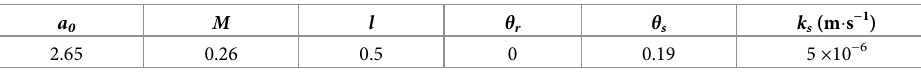
Table 3. Parameters of interest in the numerical